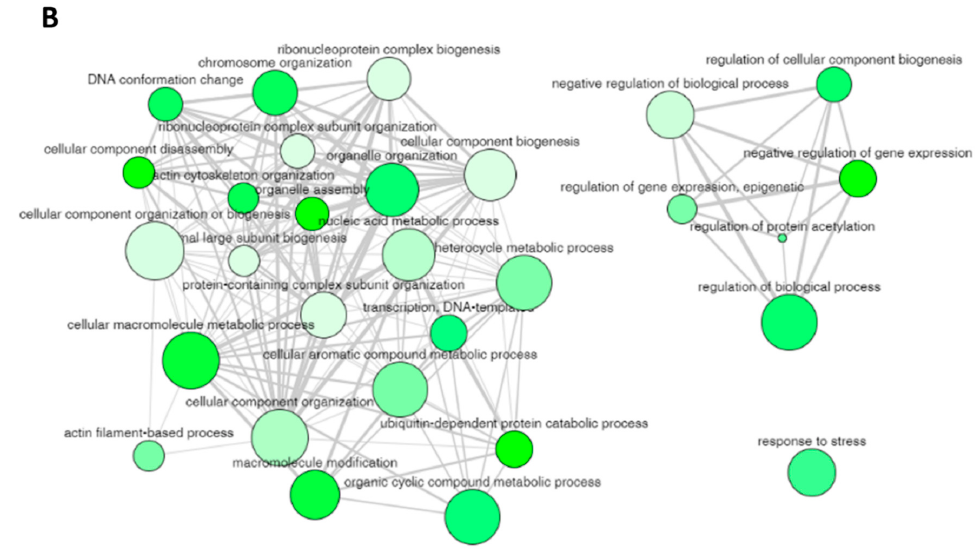
Figure 4. REVIGO analysis for the non-redundant enrichment items in the biological process. ( A ) The 29 non-redundant enrichment items in the biological process that were retained in REVIGO analysis obtained from DAVID database with the corresponding p -value of these items (the dotted line represents p -value = 0.05). ( B ) Cluster between the non-redundant items with similar biological process. The non-redundant terms are represented by bubbles and the color of the bubbles illustrate the user-provided p -value (lowest p -value is light green color whereas the highest p -value = 0.05 has dark green color). The size of the bubbles indicates the frequency of each GO term identified in the Gene Ontology Annotation database (larger bubbles are for more general terms). The width of the line connecting the bubbles represents the degree of similarity.